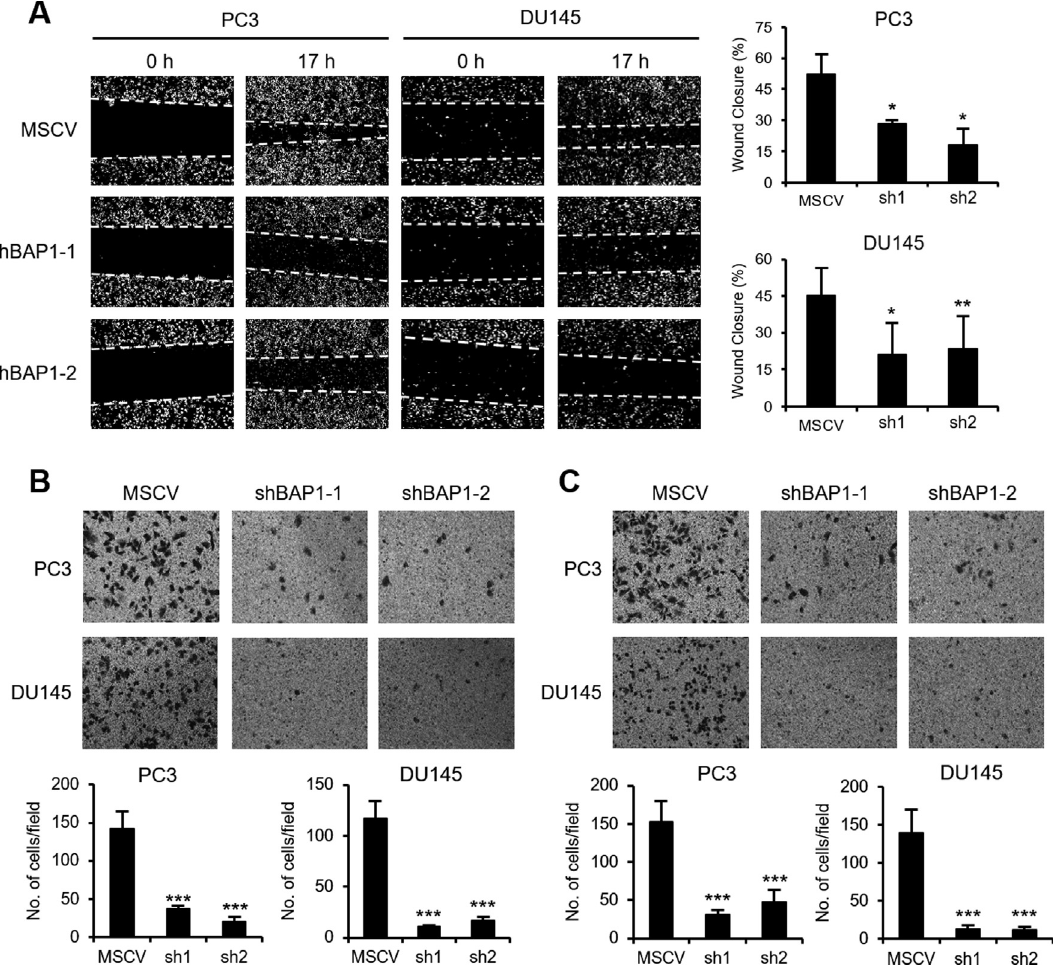
Figure 3 - BAP1 promoted the migration and invasion abilities of prostate cancer cells. (A) Wound healing assays on PC3 and DU145 cells with BAP1-knockdown. Values are expressed as the mean (cid:7) SD of three independent experiments. (B) Transwell migration assays on PC3 and DU145 cells with BAP1-knockdown. Values are expressed as the mean (cid:7) SD of three independent experiments. (C) Matrigel invasion assays on BAP1-knockdown PC3 and DU145 cells. Values are expressed as the mean (cid:7) SD of three independent experiments. The p values were calculated using Student’s t -test. * p < 0.05, ** p < 0.01, and *** p <